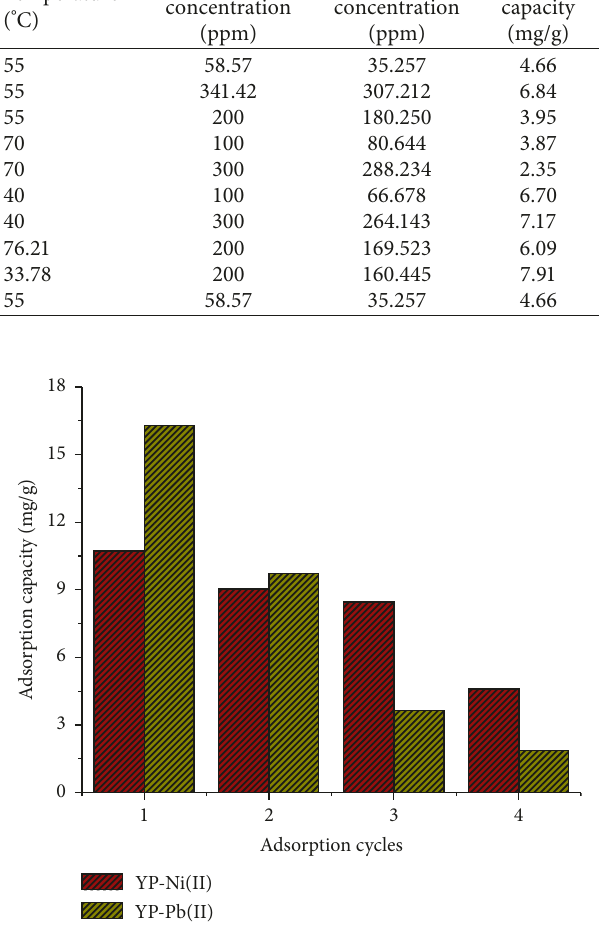
Figure 4: Adsorption capacity of nickel and lead onto yam peels biomass over adsorption cycles. Table 4: Fitting data of heavy metals adsorption onto yam peels according to kinetic